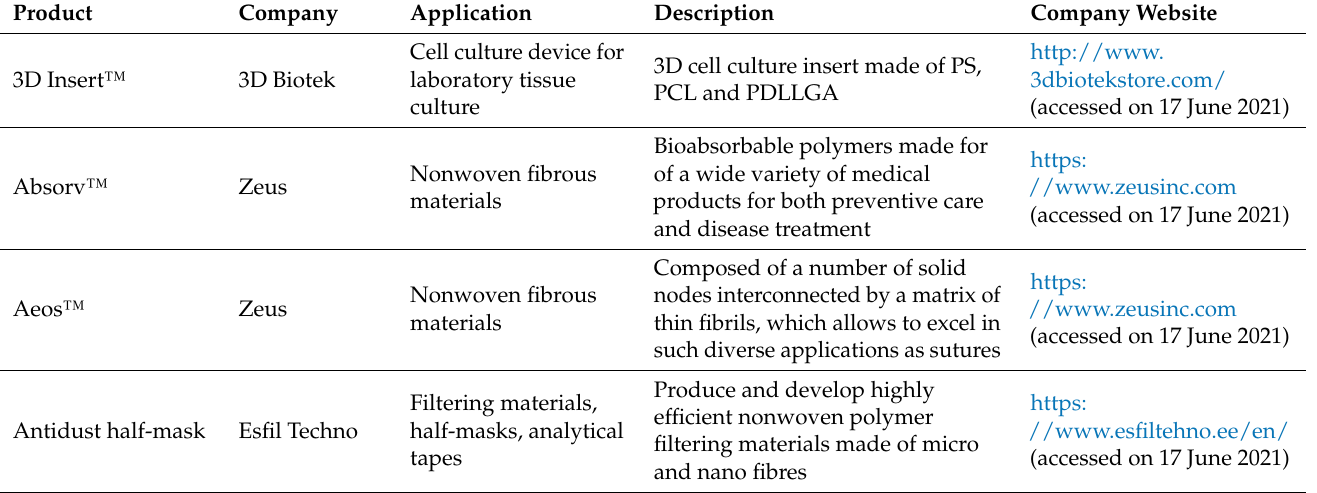
Table 1. Commercial electrospun nanofiber-applied